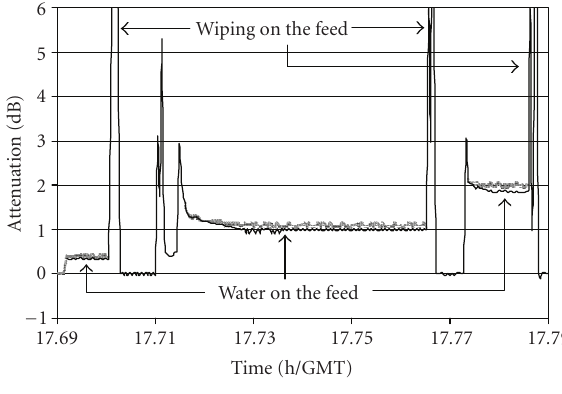
Figure 3: Experiment spraying on the